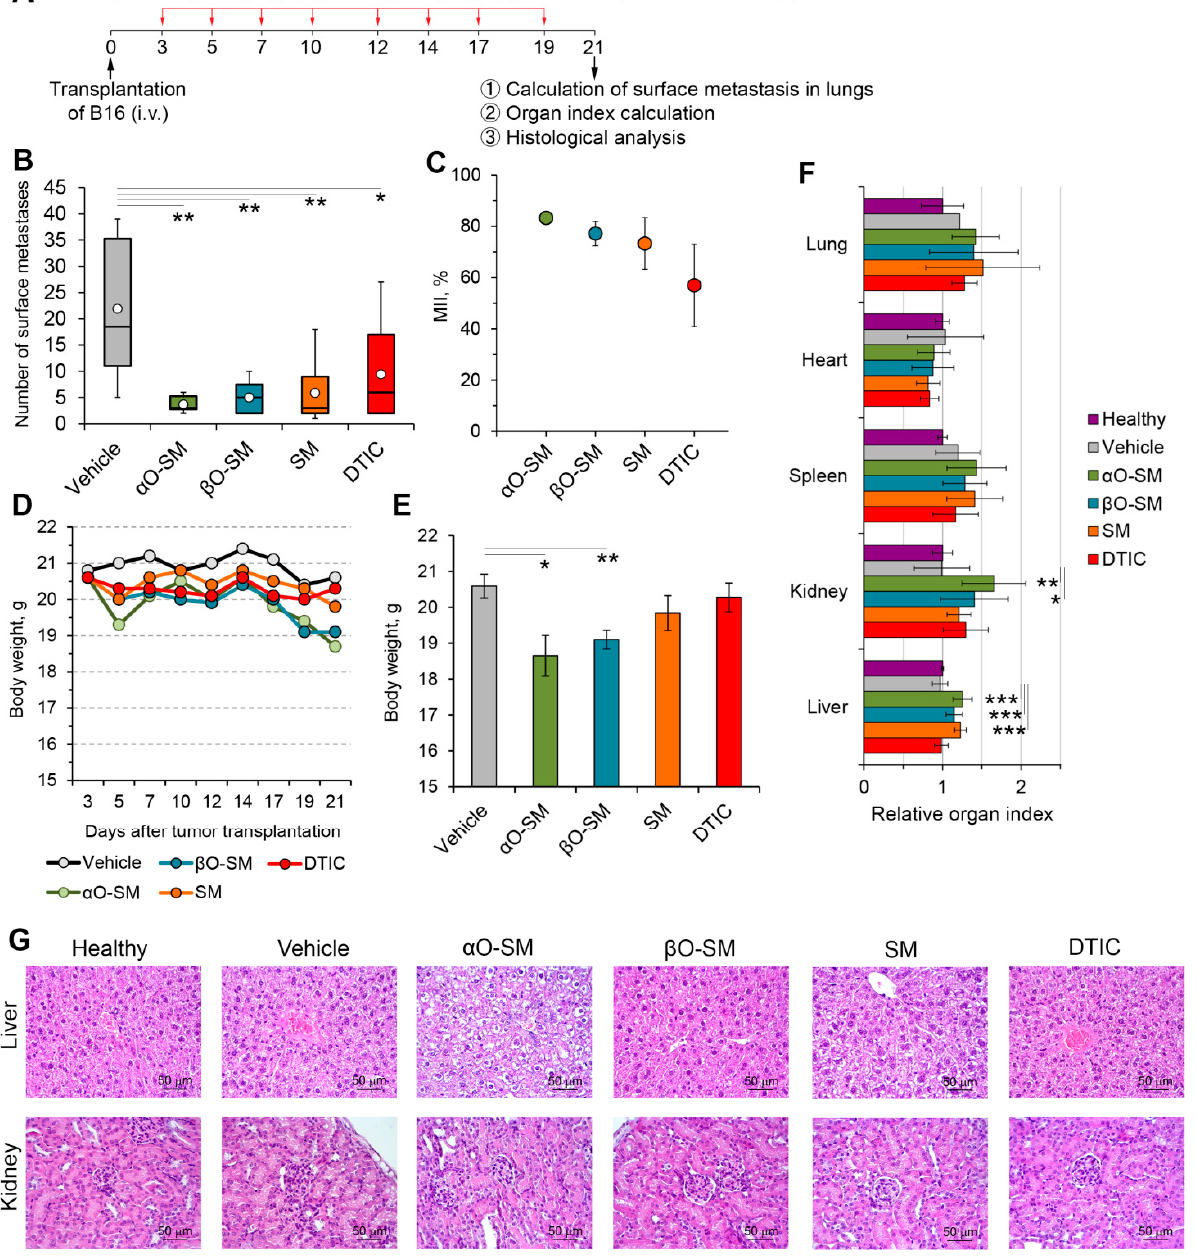
Figure 4. Anti-metastatic activity and toxicity of α -O-SM and β O-SM on the B16 melanoma model in vivo. ( A ) Experimental setup. A metastatic model of B16 melanoma was induced by the intra- venous (i.v.) injection of B16 cells (10 6 cells/mL) in C57Bl6 mice. On day 4 after tumor transplantation, mice were treated with intraperitoneal (i.p.) injections of α -O-SM , β O-SM or SM in 10% Tween-80 (30 mg/kg) or 10% Tween-80 (vehicle) thrice a week, receiving eight injections in total. Dacarbazine ( DTIC ) in water for injections (40 mg/kg, i.p.) was used as the reference drug. The mice were sacrificed on day 21 after tumor transplantation. ( B , C ) The number of surface metastases ( B ) and metastasis inhibition index (MII) ( C ) in mice with B16 melanoma after administration of α -O-SM , β O-SM , SM or DTIC . D - F . Toxic effects of triterpenoids in mice with B16 melanoma. The dynamics of body weight during the experiment ( D ), body weight at the end of experiment ( E ) and organ indexes ( F ) of mice with B16 melanoma after α -O-SM, β O-SM, SM and DTIC administration. The organ indexes of mice were calculated as (organ weight/body weight) and normalized on